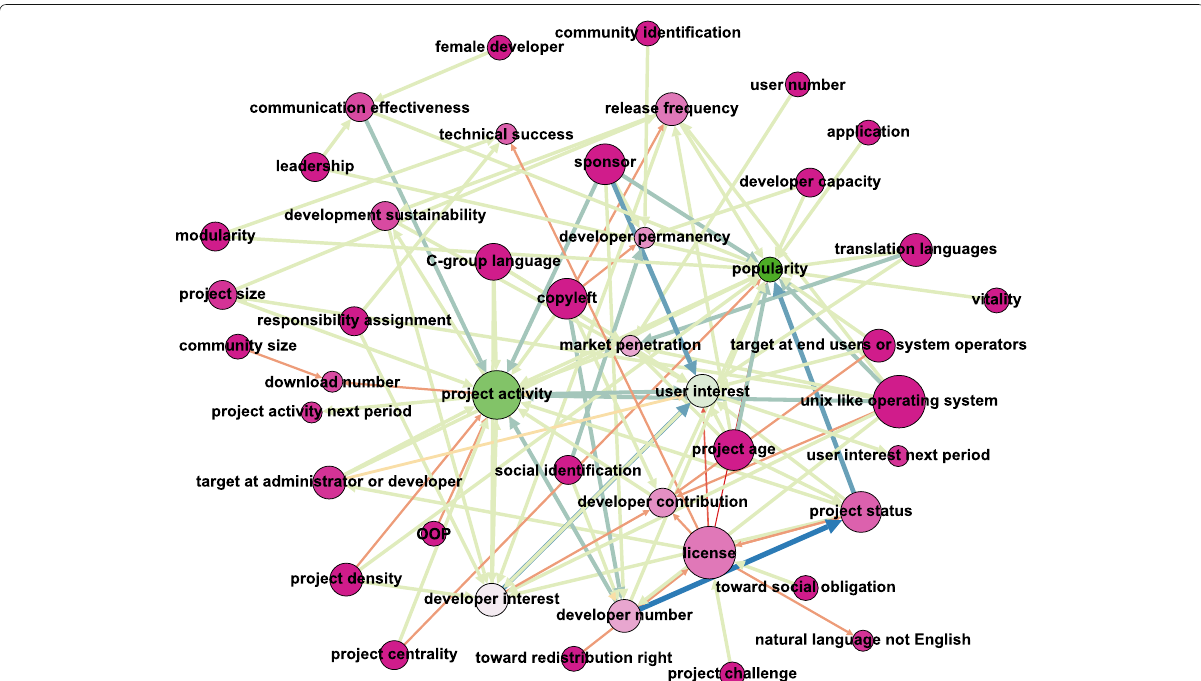
Fig. 2 This is the correlation between the indicators evaluated above. The color of one node represents the out-degree of the node, and the size of one node represents the in-degree of the node. Out-degree indicates the number of edges connected from a node. In-degree indicates the number of edges attached to a node. The color of the node transforms from dark pink to white and even to green. The heavier the pink of the node, the lower its in-degree. And, the heavier the green of the node, the higher its in-degree. What’s more, the larger the size of the node, the higher its out-degree. There are also different colors of edges, such as yellow, orange, and blue. The color of the edge depends on the weight of the correlation of two nodes. If the correlation is a positive impact, the color of the edge is a warm color; Otherwise, the color is a cold color